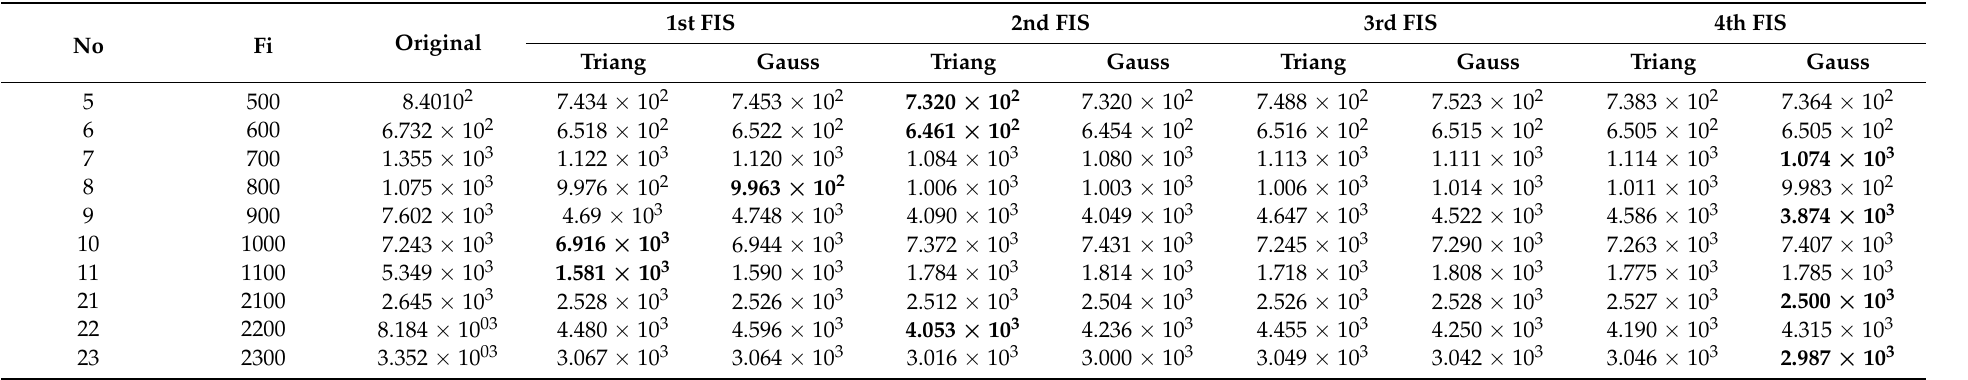
Table 5. Result of DBSA using IT2FS in CEC2017